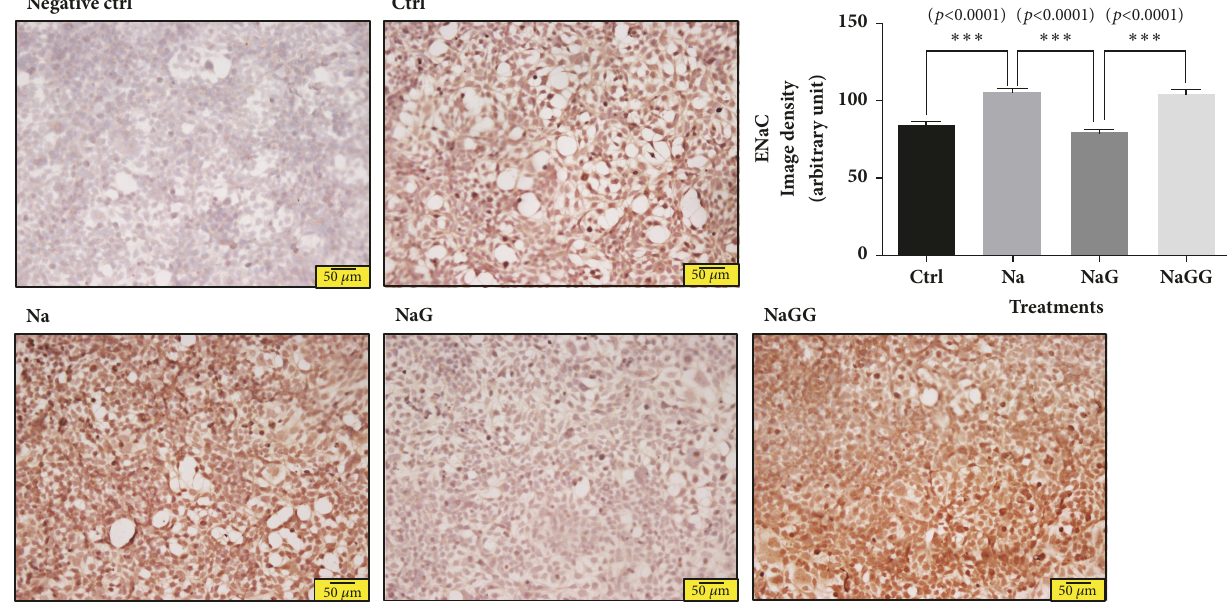
Figure 4: Imm u n o c y t o c h emistr y fo r E NaC in HEK293 cells treate d w it h NaCl , 6 - g in g er o l , an d GS K0660 . In HEK293 cells, the abnormal ENaC protein expression induced by NaCl treatment was normalized by 6-gingerol treatment. The effect of 6-gingerol was reversed by pretreatment with a PPAR 𝛿 antagonist. Magnification is 200 times. All experiments were repeated three or more times. The statistical significance between the two experimental groups was marked as ∗∗∗ p < 0.001. Meaning of indications: Ctrl indicates an untreated normal control group, Na indicates an NaCl treated group, NaG indicates an NaCl and 6-gingerol treated group, and NaGG indicates an NaCl, 6- gingerol, and GSK0660 treated